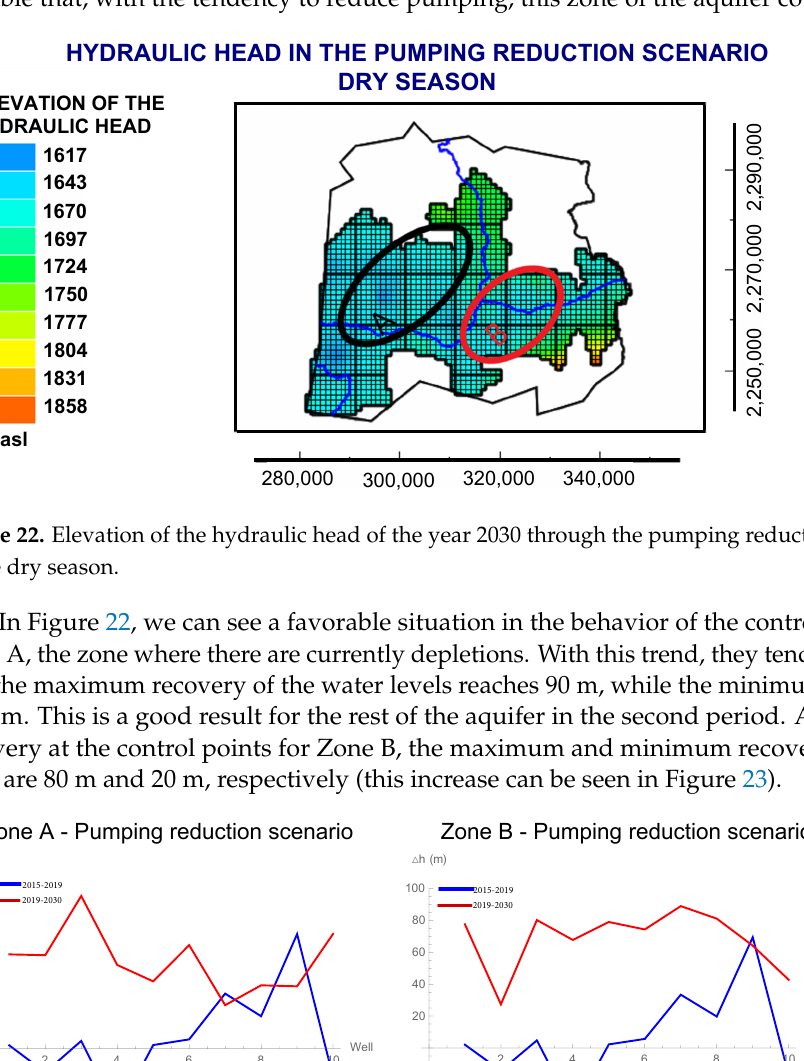
Figure 23. Variation of the hydraulic head in the pumping reduction scenario of the dry Figura 3.13: Variaci´on de la carga hidr´aulica en el escenario Reducci´on de bombeo de la Temporada de Secas.